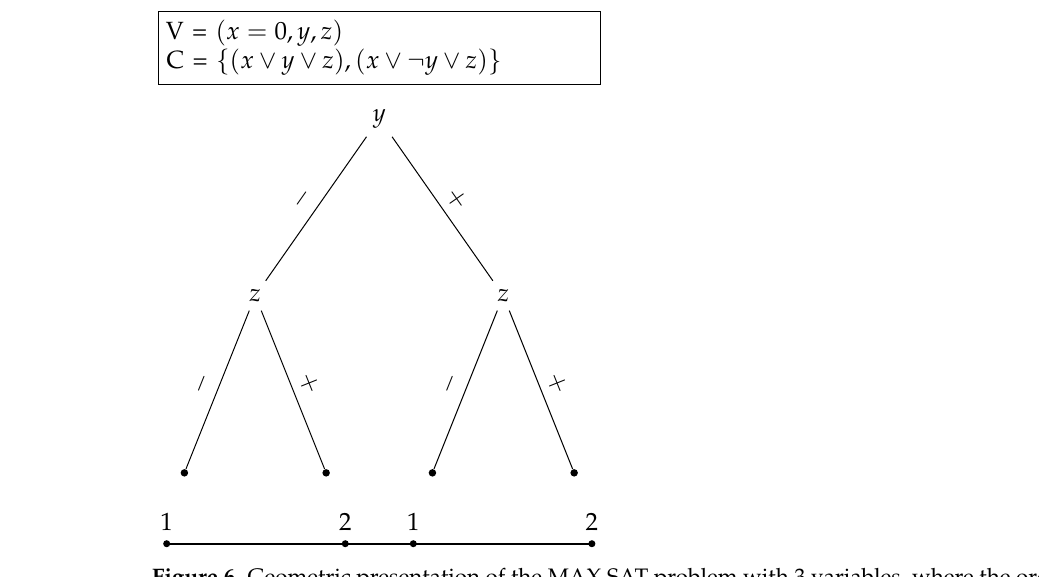
Figure 6. Geometric presentation of the MAX SAT problem with 3 variables, where the order of the variables is ( x = 0, y , z ) (The numbers on the bottom imply the clauses are satisfied by the